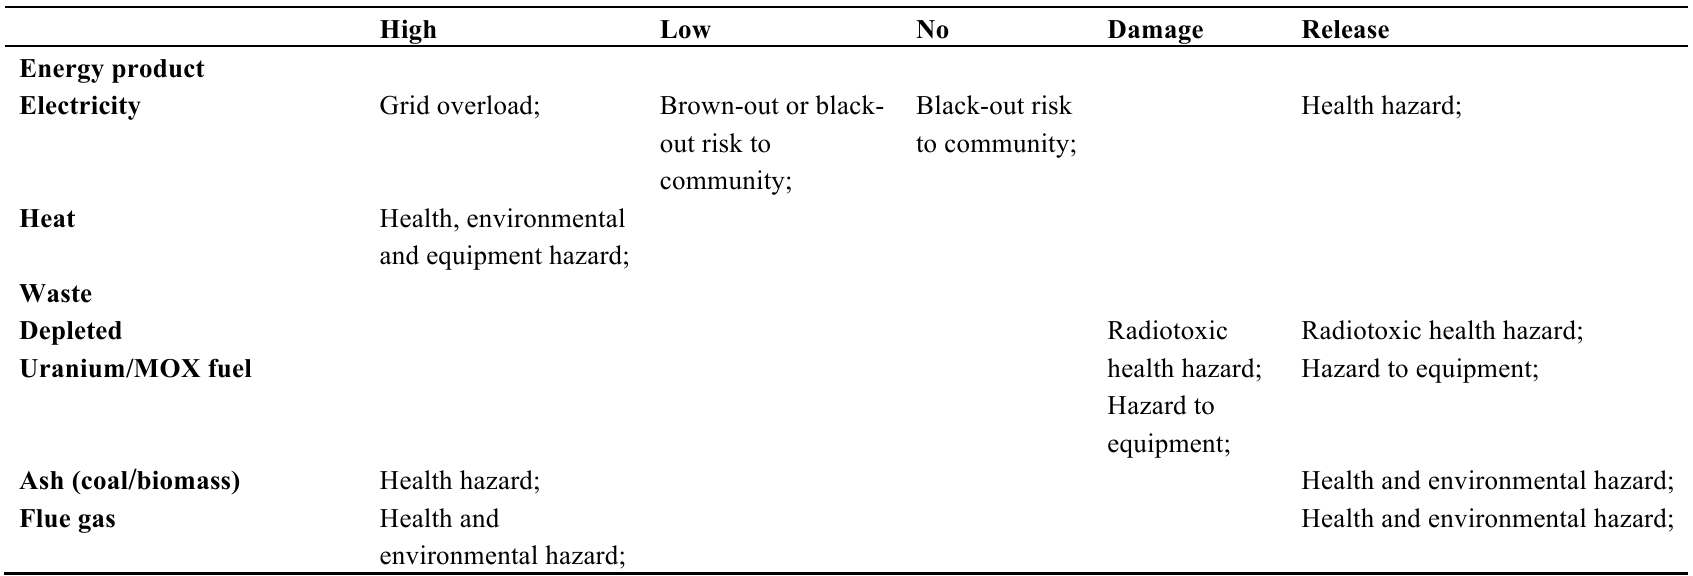
Table A2. Adapted-HAZOP assessment of risks associated with outputs of energy systems.